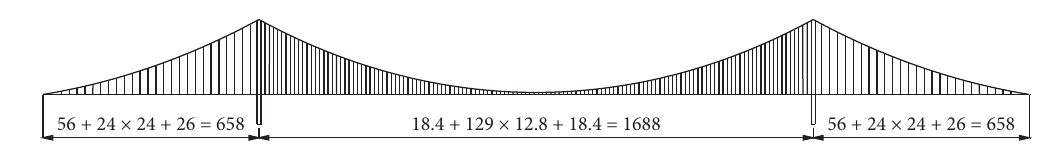
Figure 5: Overall elevation of the suspension bridge.